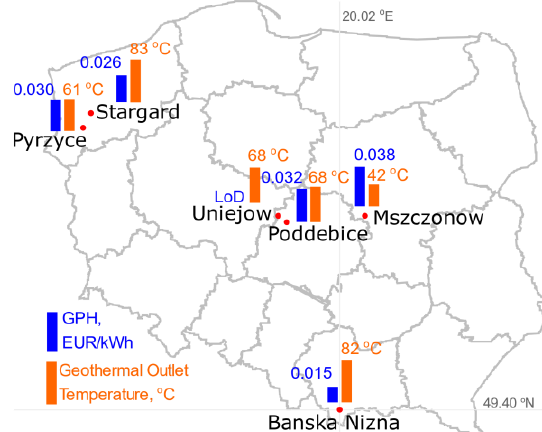
Figure 3. Map of Poland with geothermal sources and heat price (without distribution and charge for power). Source: own study based on [42,43].